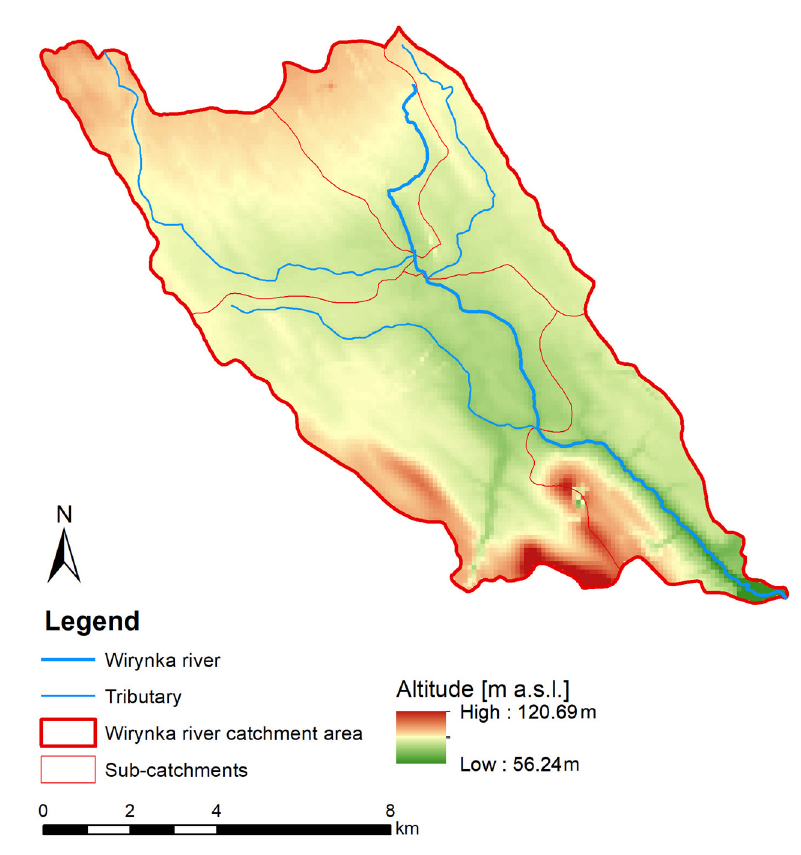
Figure 2. Digital elevation model (DEM) for the Wirynka catchment.